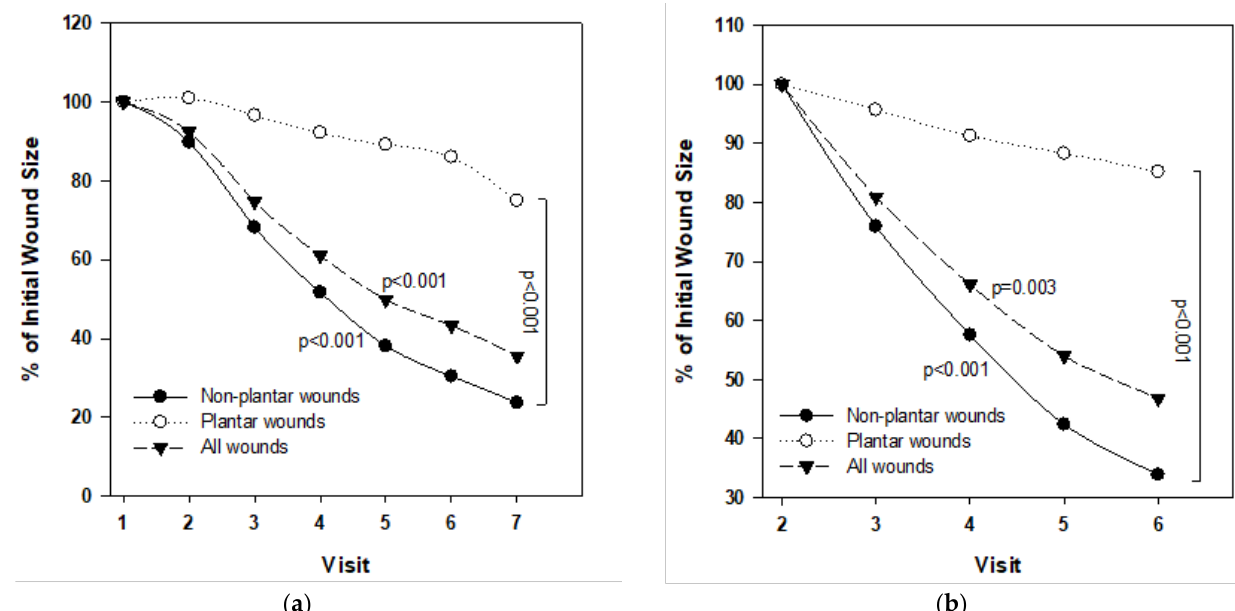
Figure 3. Repeated-measures ANOVAs of the mean wound size reduction and difference between the WBW and NWBW subgroups during the whole study ( a ) and during the Treatment Phase only ( b ).